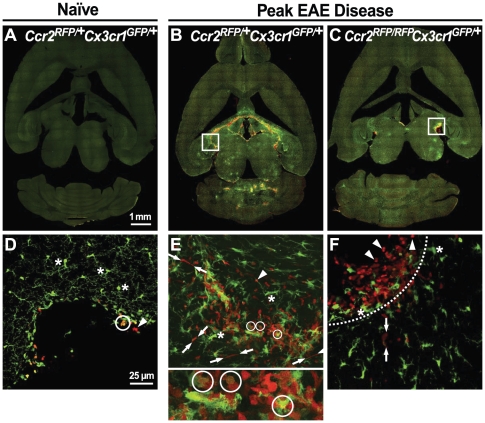
Expression of CX3CR1 and CCR2 in brain lesions of mice with EAE.(A–C) Low-magnification epifluorescence images of naive Ccr2RFP/+Cx3cr1GFP/+ (A), diseased Ccr2RFP/+Cx3cr1GFP/+ (B), and Ccr2RFP/RFPCx3cr1GFP/+ (C) brains show the extent of inflammation and anatomical location of the lesions. Higher magnification views of the boxed areas are shown in panels D–F. Confocal image of healthy perivascular (D) tissue shows GFP+ microglia (asterisks), small round RFP+ cells (arrowhead), and double-positive cells (circles). (E) Parenchymal lesion in a Ccr2RFP/+Cx3cr1GFP/+mouse and (F) a perivascular lesion from a Ccr2RFP/RFPCx3cr1GFP/+ mouse at peak EAE disease. Dashed line in (F) indicates the approximate perivascular boundary. Within EAE lesions, note RFP/GFP double-positive cells (circles), GFP+ activated microglia (E, F; asterisks), large elongated RFP+ cells (E, F; arrows), and small round RFP+ cells (E, F; arrowheads). Small RFP+ cells were CD3+ (not shown). The particularly elongated RFP+ cells in the Ccr2RFP/+Cx3cr1GFP/+ lesion (E) were much less abundant in the Ccr2RFP/RFPCx3cr1GFP/+ lesion (F).